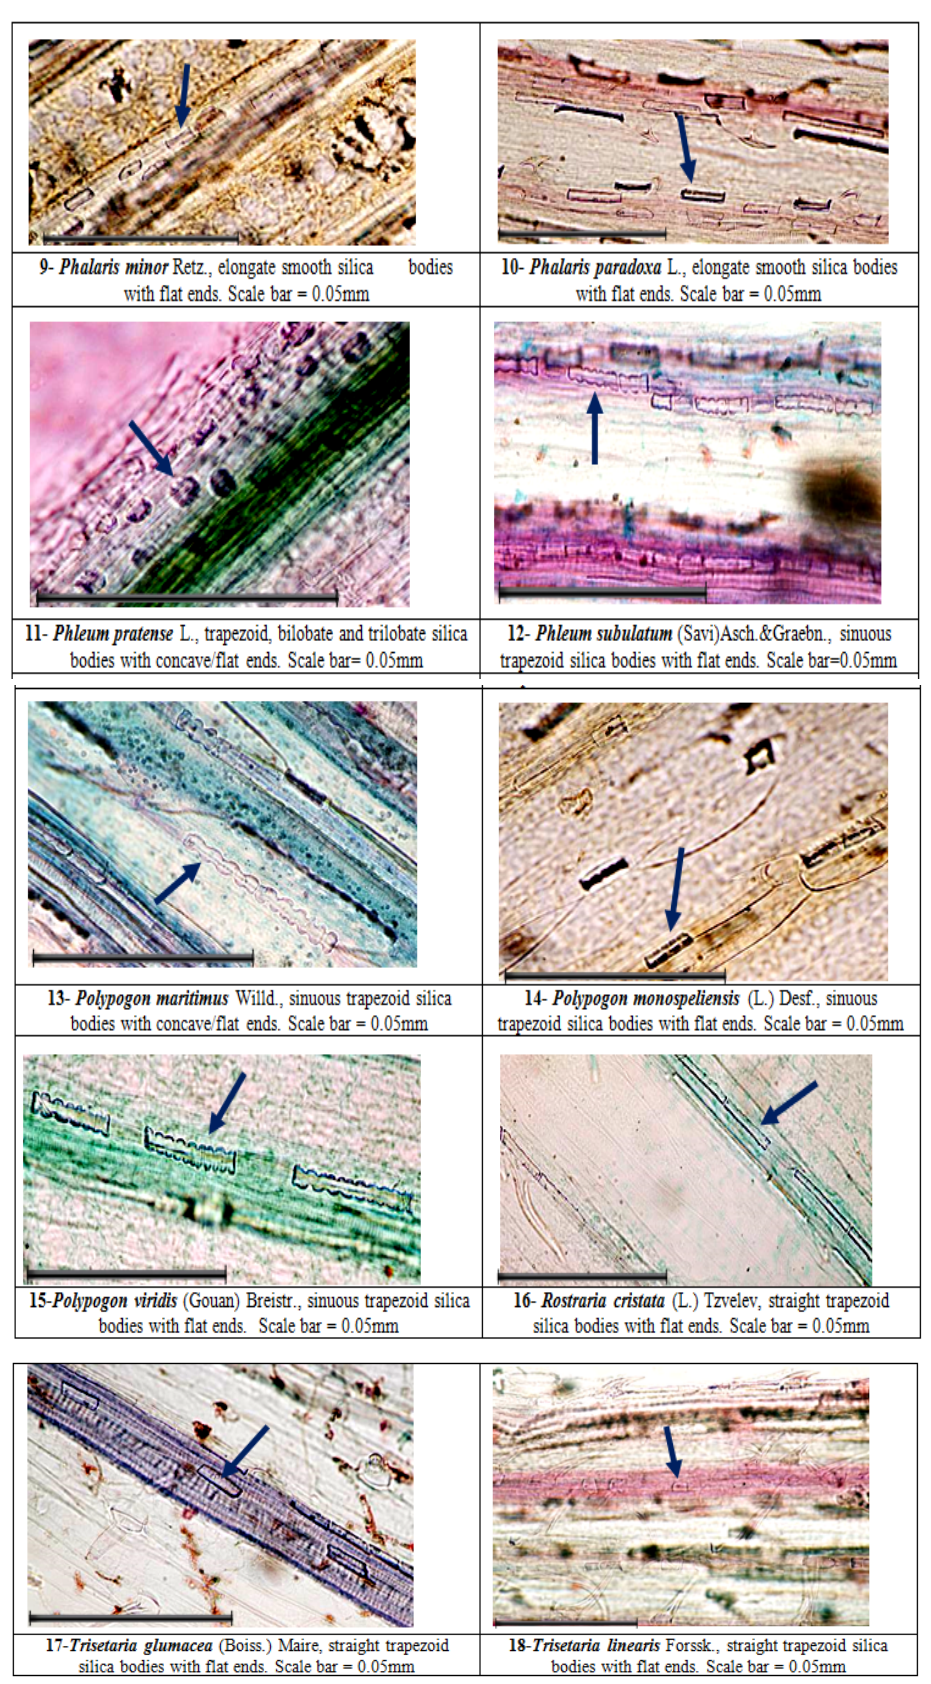
Plate 1. Light micrographs of the studied taxa of tribe Aveneae, showing their silica bodies structure